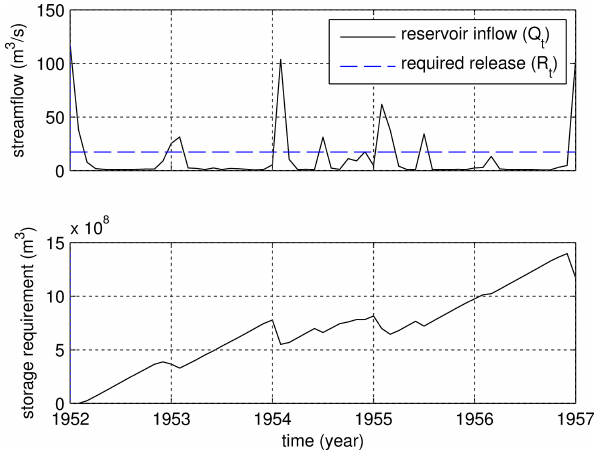
Figure 2. Example of sequent peak algorithm: (a) time series of streamflow ( Q t ) and required release ( R t ) , and (b) corresponding storage requirement: the reservoir would be designed based on the maximum